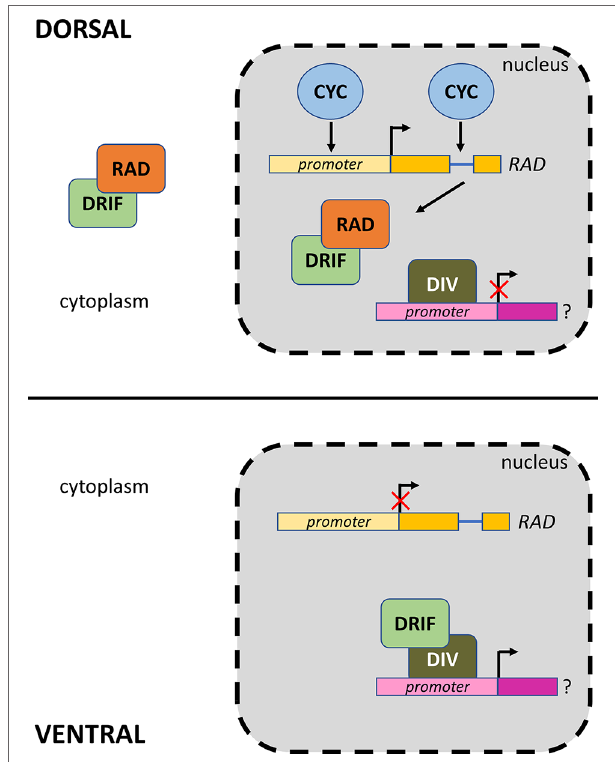
FIgURE 1 | Model of interaction of CYC, DIV, RAD, and DRIF proteins in Antirrhinum majus (modified from Raimundo et al., 2013). The DIV and DRIF proteins are expressed both in the dorsal and ventral parts of the flower. In the dorsal domain, the CYC protein interacts with the promoter and intron of the RAD gene, activating its expression. The RAD protein binds to DRIF and prevents the formation of the DIV/DRIF complex, thus inhibiting ventralization. In the ventral domain, the absence of RAD permits the formation of the DIV/ DRIF complex that controls downstream genes involved in the